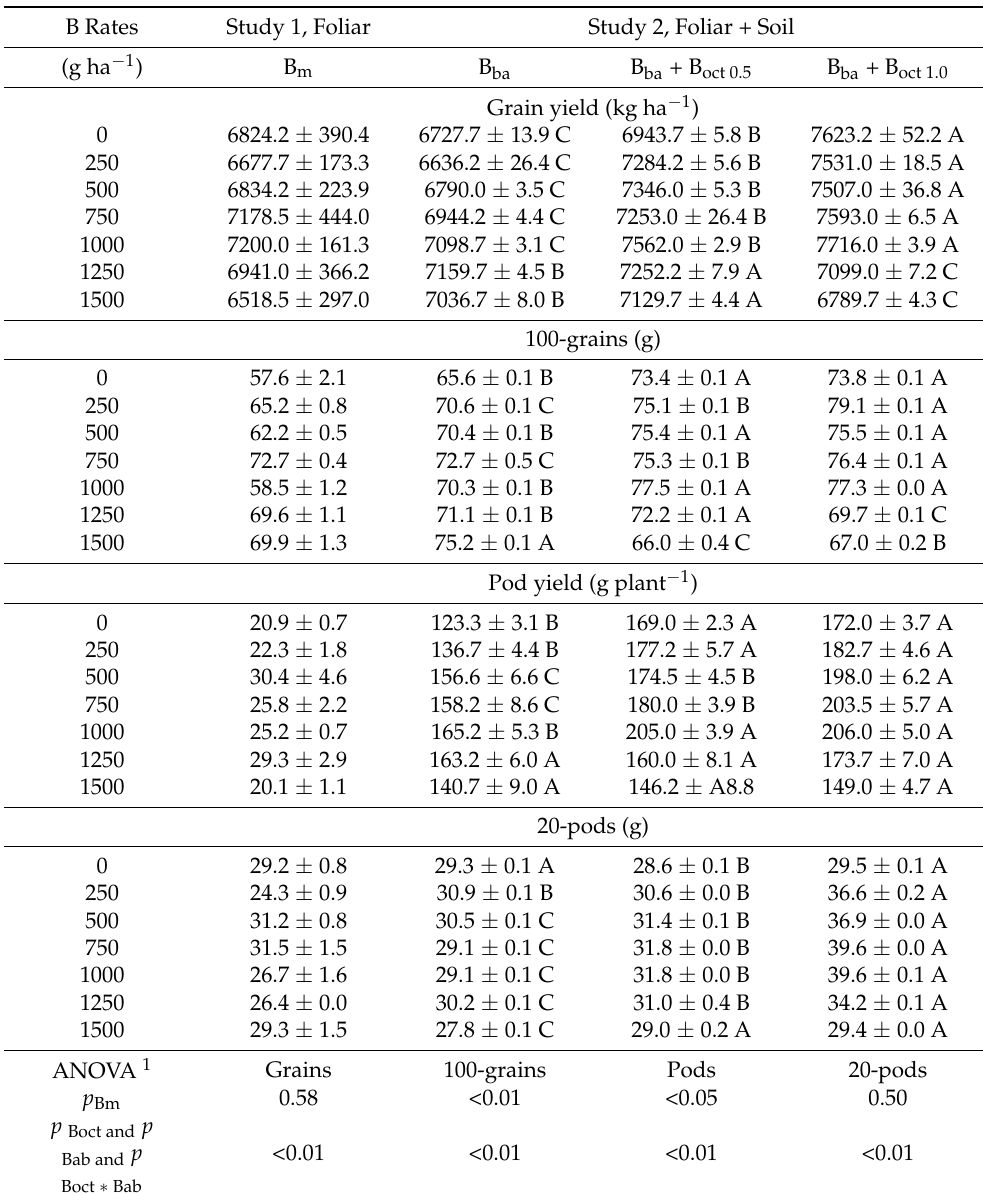
Table 2. Peanut yield of grains (kg ha − 1 ), 100-grains (g), pods (g planta − 1 ), 20-pods (g) in Study 1 with foliar application of B (Bm, monoethanolamine) using six B rates (250, 500, 750, 1000, 1250 and 1500 g ha − 1 ), and in Study 2 with B application in soil using sodium octaborate (Boct) with two rates (Boct0.5: 0.5 kg ha − 1 ; and Boct1.0: 1.0 kg ha − 1 ), and the foliar B application using boric acid (Bba) with six rates (250, 500, 750, 1000, 1250, and 1500 g ha − 1 ). B Rates Study 1, Foliar Study 2, Foliar +